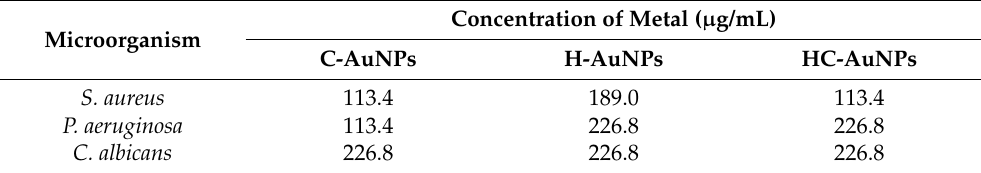
Table 6. Metal concentration related to the maximum antimicrobial activity of peptides-conjugated NPs.